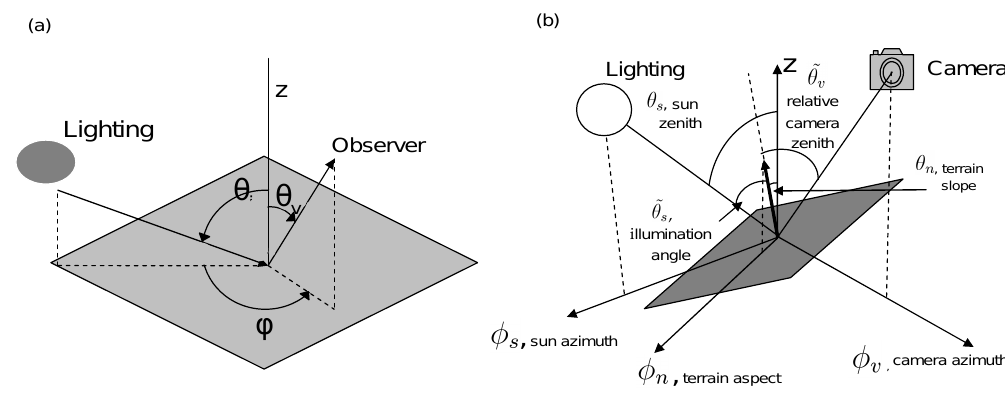
Fig. 1. (a) Geometric configuration of the lighting and observation directions. (b) Definition of the relative geometry between a glacier pixel, the sun, and the camera (adapted from Sirguey et al., 2009).